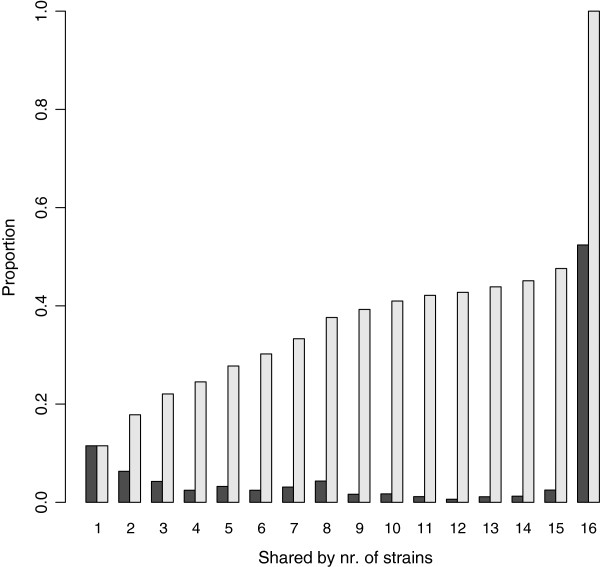
Overview of relative and cumulative proportions of shared gene families as the number of included genomes increases. Each pair of bars along the x-axis represents the relative (dark grey) and cumulative (light grey) proportions of gene families that are shared among the indicated number of strains. E.g. the first pair of bars indicates the proportion of gene families that were found in only one of the 16 strains, the second pair indicates the proportion shared by two of the 16 strains, while the final pair indicates the proportion of the pan-genome that is common to all 16 strains. All duplicated gene annotations were removed for this analysis. 11.5% of annotated genes are unique to one strain while 52.4% are common to all. The total number of gene families in the pan-genome is 6152.